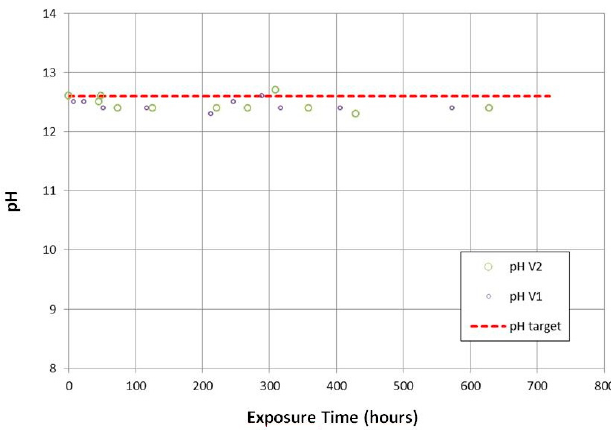
Figure 3. Experimental pH level during exposure.